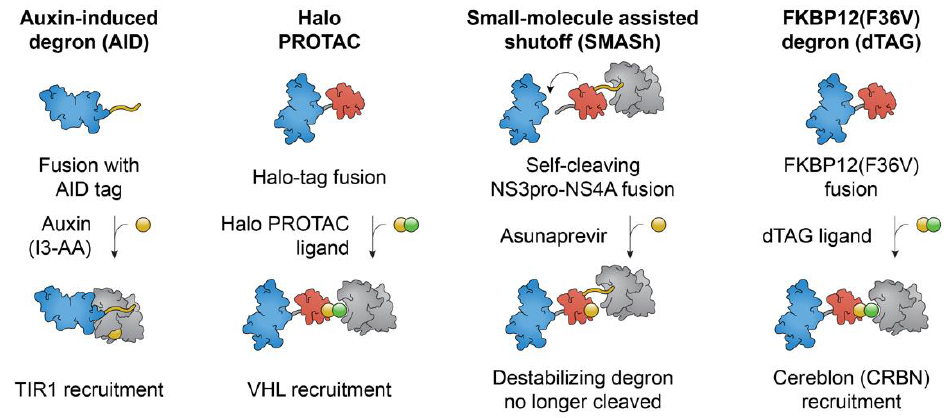
Figure 4. Genetically encoded fusion strategies for targeted protein degradation. A variety of fusion tags exist that are suitable for orthogonal targeted protein degradation strategies. These strategies require recombinant expression in experimental systems.